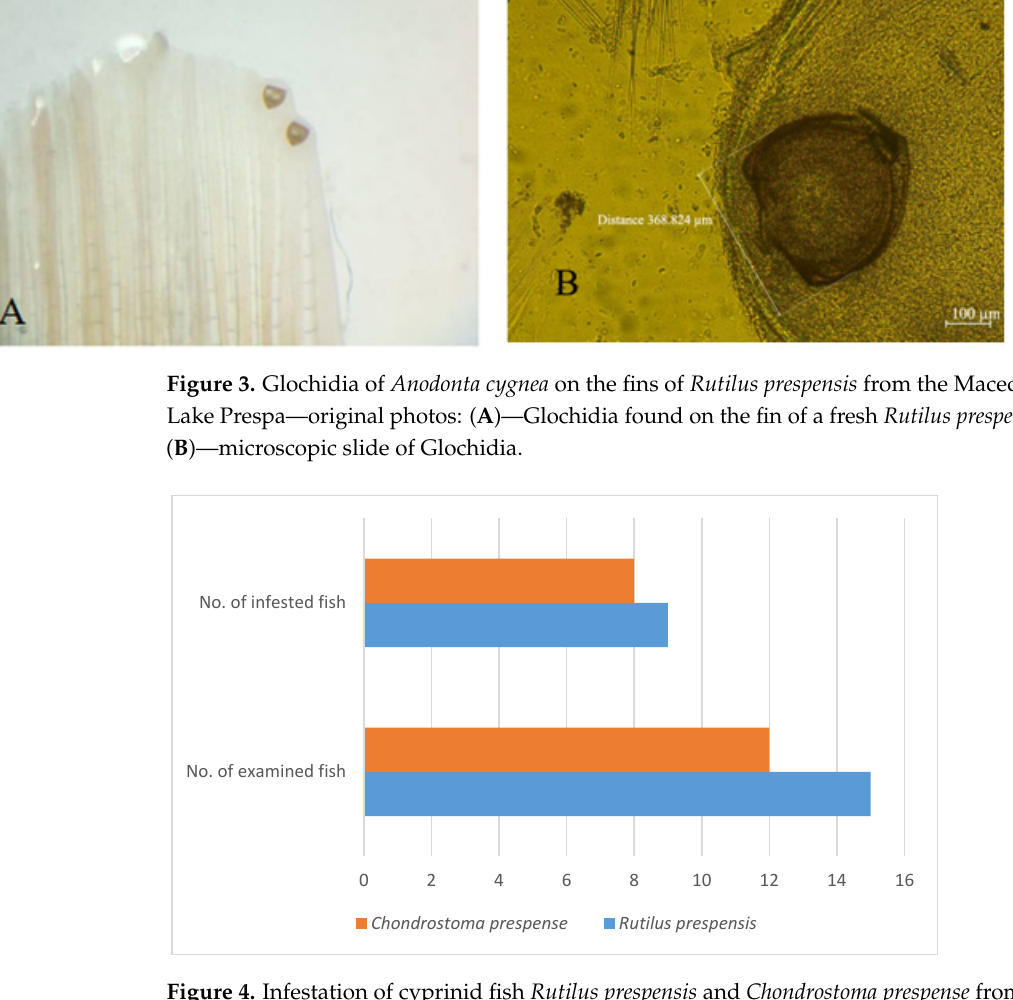
Figure 4. Infestation of cyprinid fish Rutilus prespensis and Chondrostoma prespense from Lake Prespa with glochidia of Anodonta cygnea .